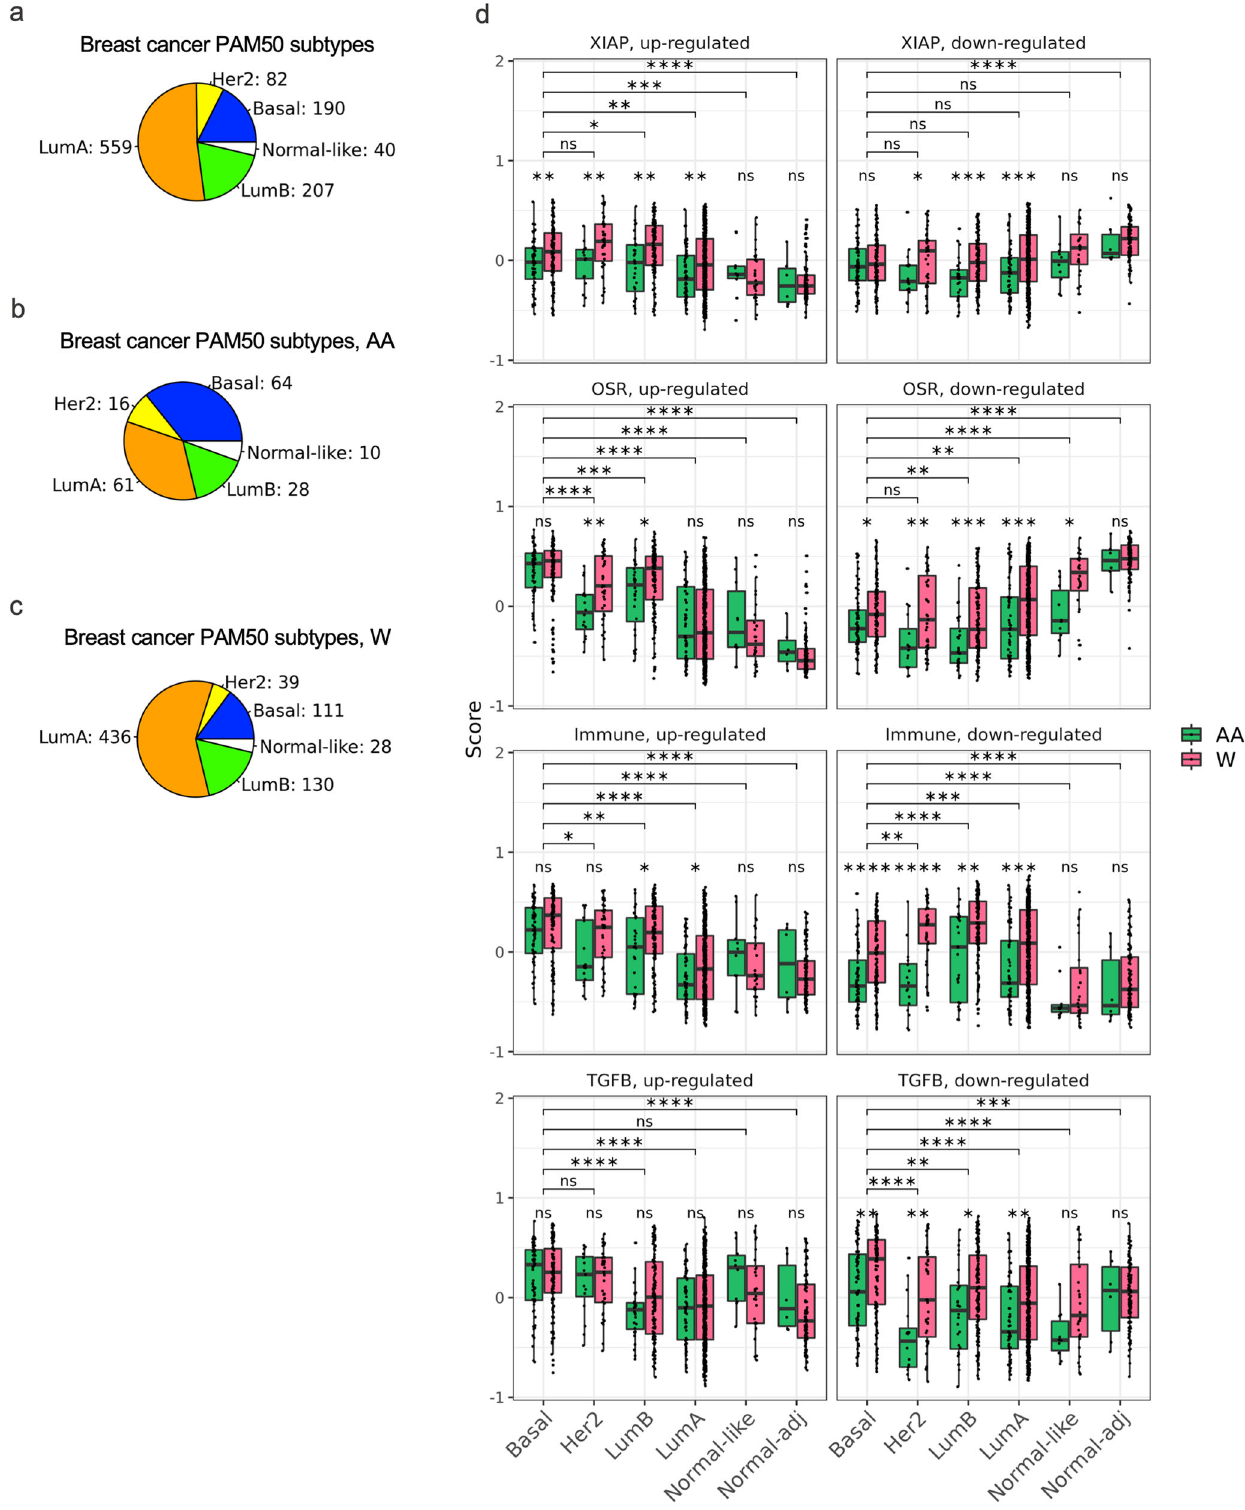
Fig. 1 Number of breast cancer samples in TCGA by de fi nition, race, and PAM50 subtypes. Pie charts depicting the number of breast cancer samples in TCGA PAM50 subtypes: Basal, Her2, LumB, LumA, Normal-like for all samples ( a ), for samples from AA patients ( b ), or for samples from W patients ( c ). d Scores of the expression level of XIAP, OSR-, Immune-, and TGF β -related gene signatures in breast cancer subtypes. Box plots overlaid with scatter plots depicting the calculated score for XIAP-, OSR-, immune-, and TGF β -related ASR gene signatures in the indicated breast cancer subtypes and strati fi ed by patient race, AA or W. The Wilcoxon signed-rank test was used to examine signi fi cance (*adjusted p -value < 0.05; **adjusted p -value < 0.001; ***adjusted p -value < 0.0001; and ns, not signi fi cant). The center line represent the medians and the bounds of box represent the con fi dence intervals.